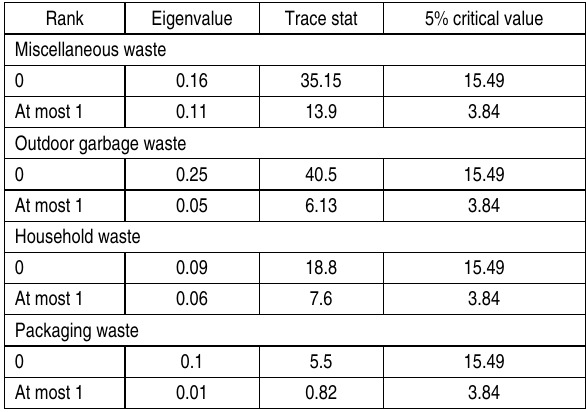
Table 3. Johansen (1991) cointegration